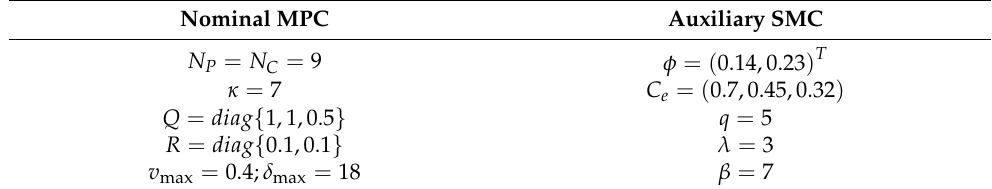
Table 3. SMC-based tube MPC.